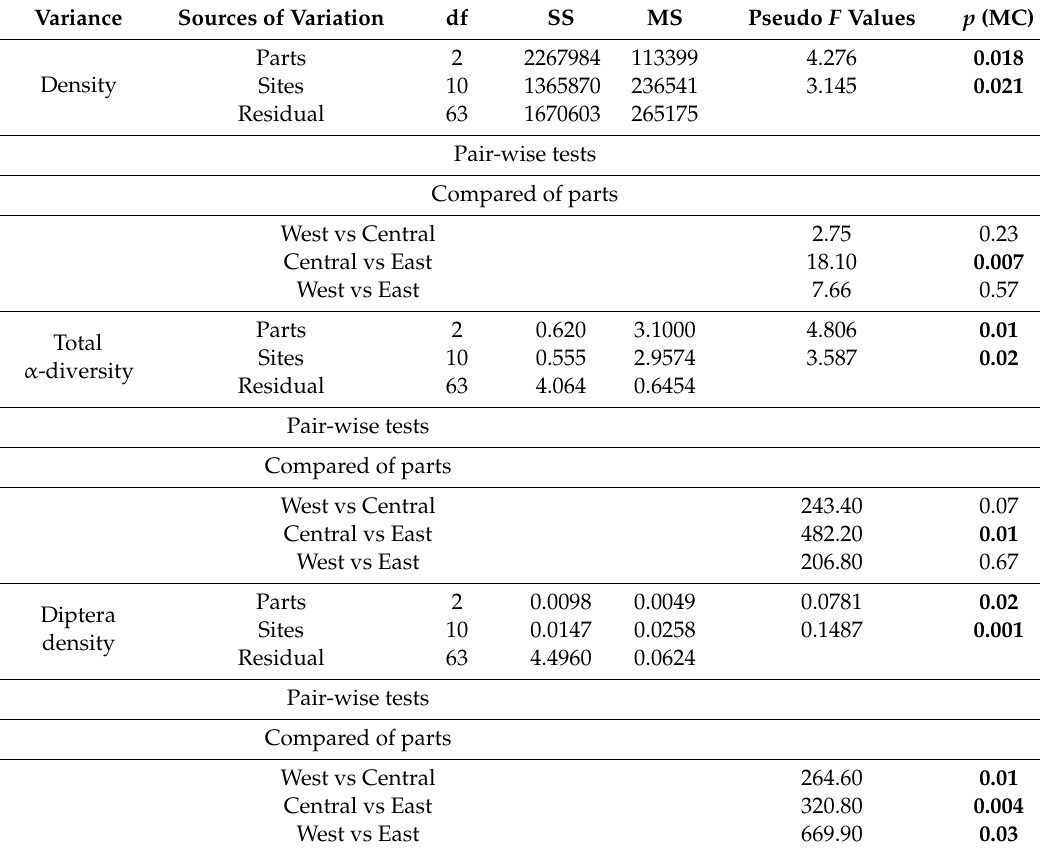
Table 6. Permutational analysis of variance (PERMANOVA) results, testing the e ff ects of three parts of Lake Łebsko (western, central, and eastern) and sampling sites on the total density, diversity of invertebrates, and density of Diptera larvae. Analysis based on Bray-Curtis dissimilarity